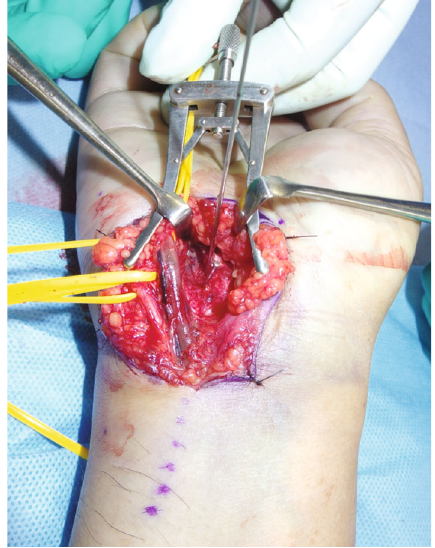
Figure 3: Intraoperative fi ndings.